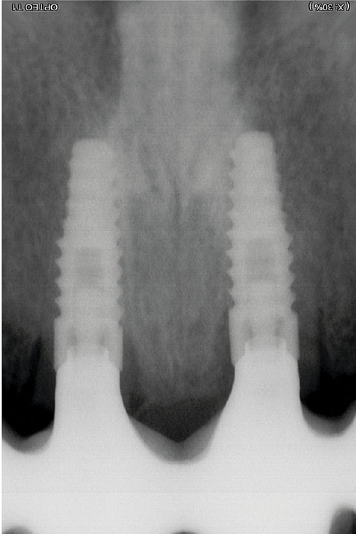
Figure 11: Control X-ray after bridge placing.